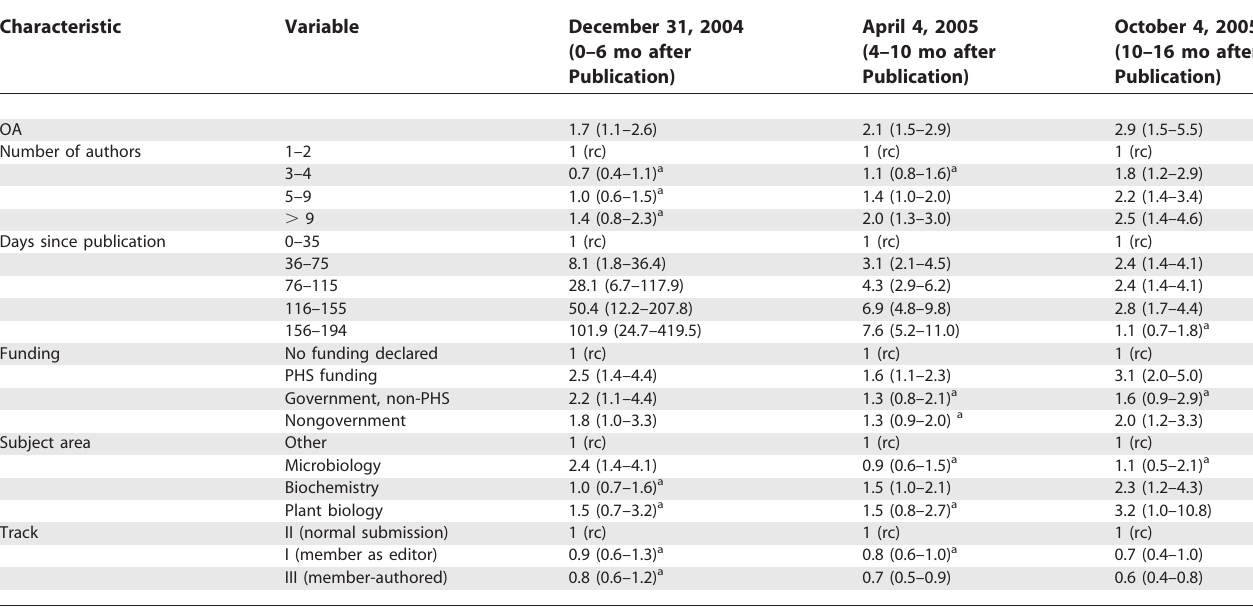
Table 3. Odds Ratios (with 95% Confidence Intervals) of Significant Predictors from a Stepwise Backward Logistic Regression Model (for Three Points in Time) with ‘‘ Cited ’’ Status as the Dependent Variable and OA Status as Well as Potential Confounders as Independent